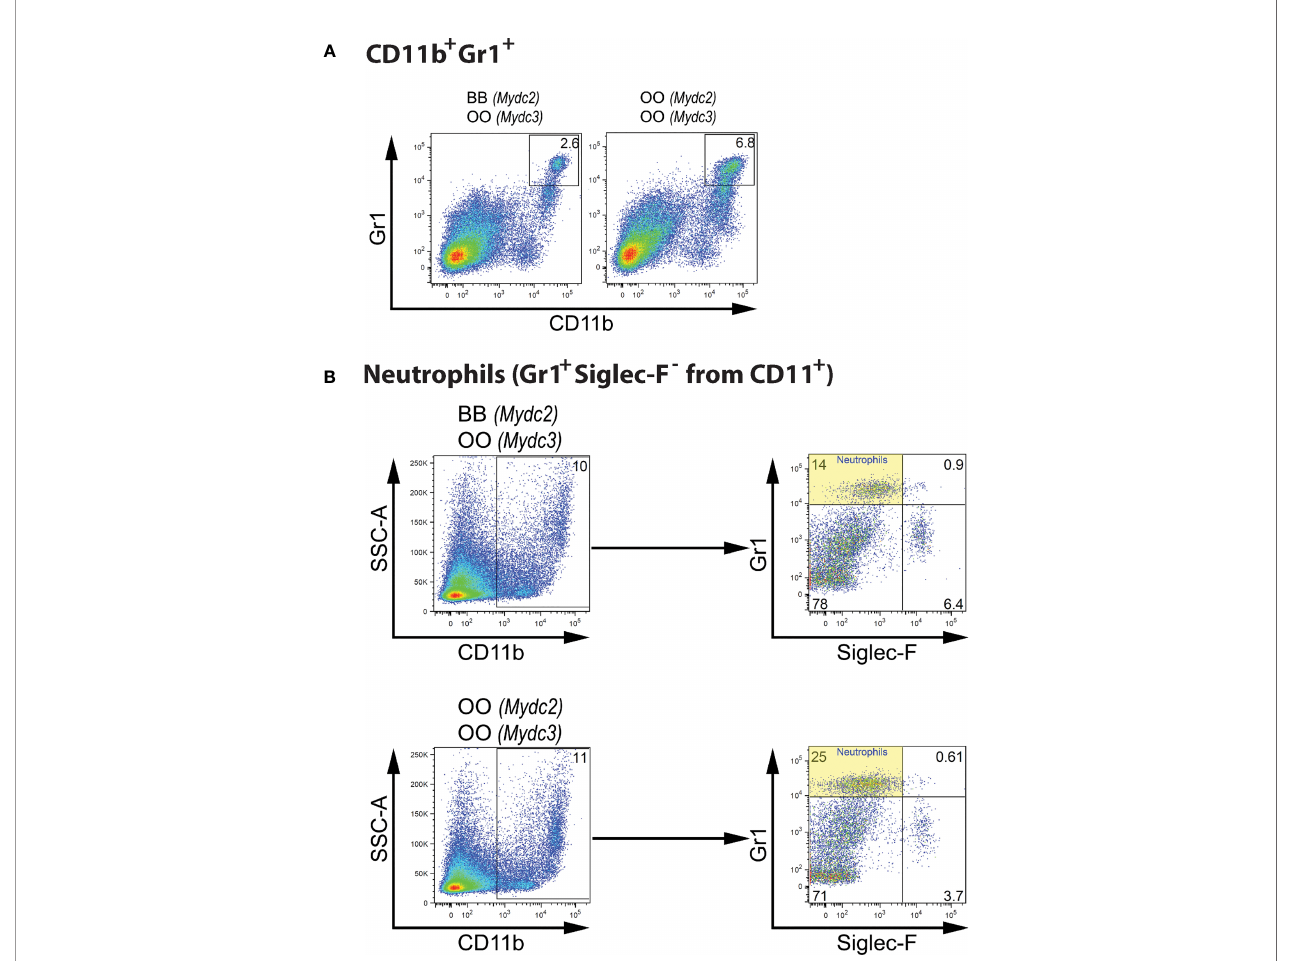
FIGURE 6 | Genetic interactions in fl uencing frequency of myeloid-derived cells. (A) Flow cytometry analysis of spleens of representative mice carrying combination of BB ( Mydc2 ) and OO ( Mydc3 ) genotypes, and OO homozygotes in both Mydc2 and Mydc3 showing the Gr1/CD11b cell surface marker status of individual cells.